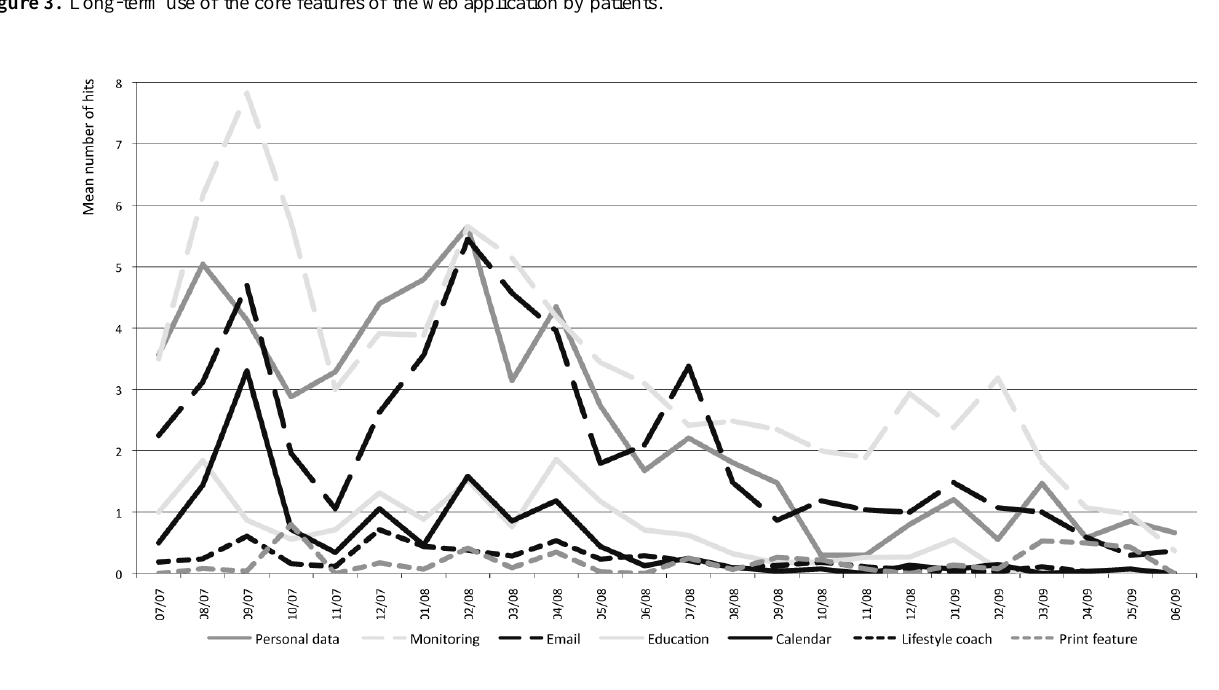
Figure 3. Long-term use of the core features of the web application by